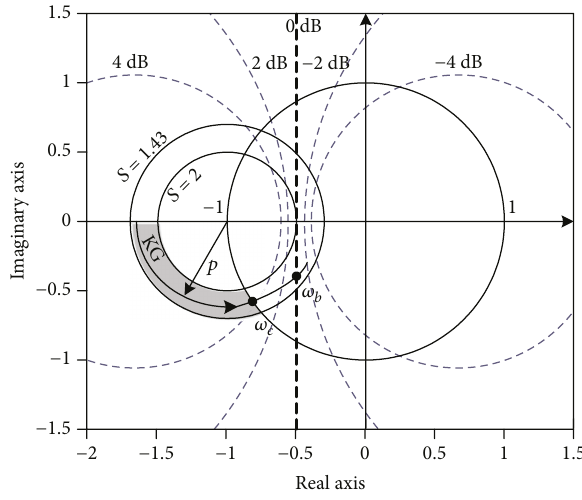
Figure 9: Nyquist locus of K j ω G j ω